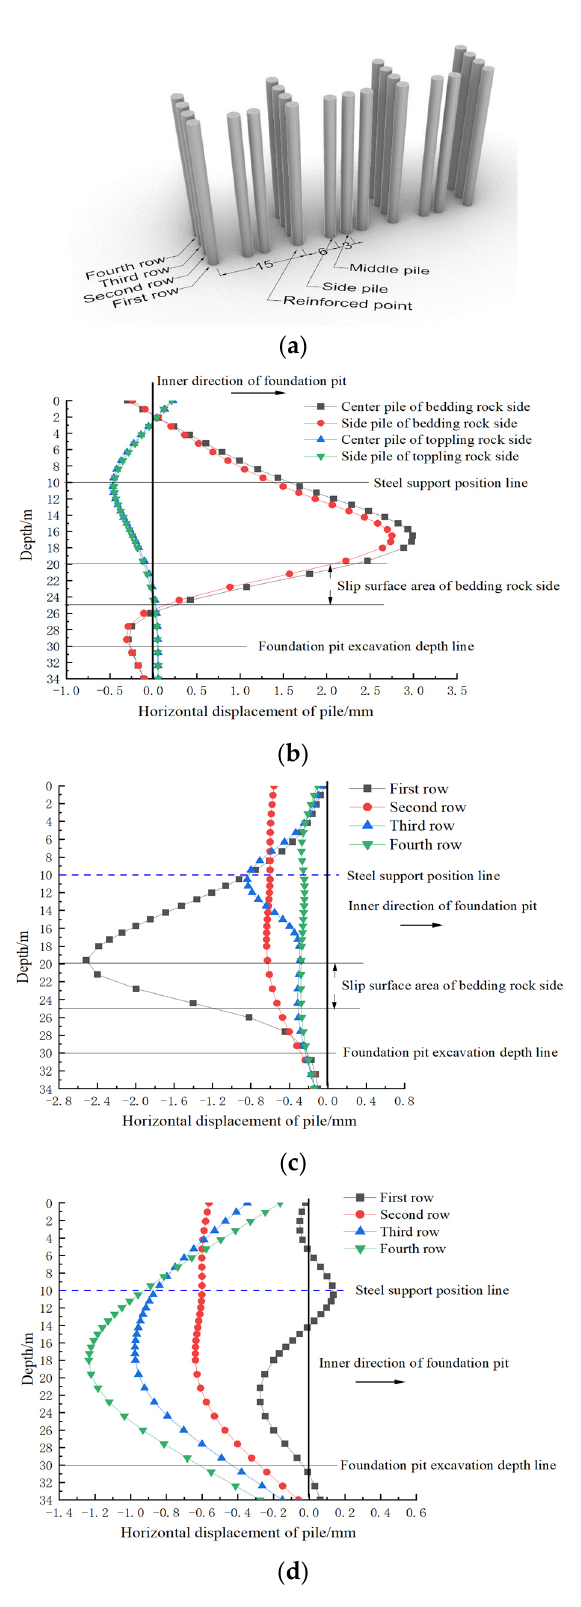
Figure 23. Stress analysis of sectionalized support system (design of sparse-dense pile). ( a ) schematic diagram of sectionalized sparse-dense pile support model (Unit: m); ( b ) displacement of retaining pile; ( c ) displacement of pile body at reinforced point (bedding rock side); ( d ) displacement of pile body at the reinforced point (toppling rock